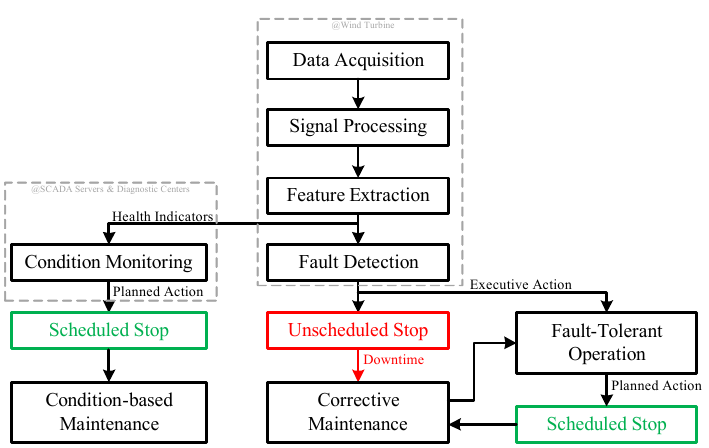
Figure 1. Condition monitoring and fault detection for wind turbines’ drive train.